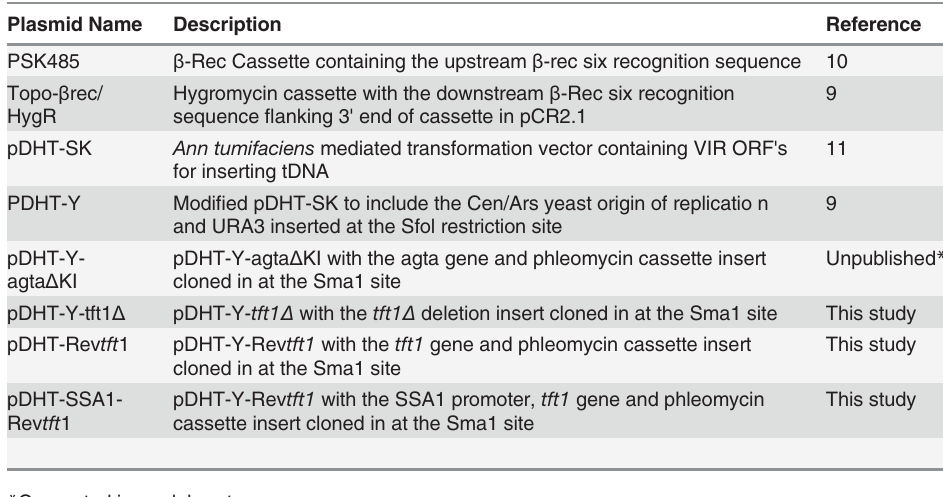
of Topo β rec/HygR plasmid [10]. The resulting plasmid was harvested from yeast and electro- porated into A. tumefaciens. The resulting strain was used for co-cultivation with spores from WT A. fumigatus (Af293) as previously described [9,11]. Both revertant strains (revtft1(tft1 Δ :: TFT1) and SSA1-revtft1 (tft1 Δ ::SSA1-TFT1) were generated from the tft1 Δ strain. The revtft1 construct contained upstream 1kb flank of the TFT1 gene with the native TFT1 ORF (TFT1KI- 1/TFT1KI-3 off genomic DNA) and the downstream 1kb flank (and TFT1KI-4/TFT1KI-6 off genomic DNA) surrounding the phleomycin resistance cassette (TFT1KI-2/TFT1KI-5 off of pDHT-Y-agta Δ KI). SSA1-Revtft1 was created in similar fashion, with the strong constitutive SSA1 promoter situated between the upstream flank and the TFT1 ORF. The construct con- tained upstream 1kb flank of the TFT1 gene (TFT1KI-1/Sup-2 off genomic DNA), the SSA1 promoter (Sup-1/Sup-4 off genomic DNA), the TFT1 ORF (Sup-3/TFT1KI-3 off genomic DNA), the Phelomycin cassette (TFT1KI-2/TFT1KI-5 off pDHT-Y-agta Δ KI), and the down- stream 1kb flank of the TFT1 gene (TFT1KI-4/TFT1KI-6 off genomic DNA). PCR and Southern blot analysis of tranformants. Genomic DNA (gDNA) was prepared from fresh mycelium as previously described [9], and gDNA concentration was determined using a NanoDrop (ND100) spectrometer. For PCR analysis of the transformed strains, gDNA was amplified with primers TFT1OL-9 and 10 Table